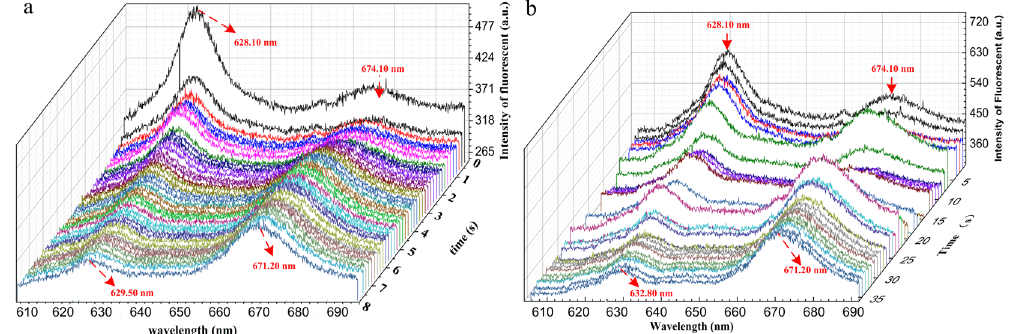
Figure 4. Monitoring the Fe 2 + and Fe 3 + combination with Protoporphyrin IX. ( a – c ) Dynamic reaction process between Fe 2 + and Protoporphyrin. The X-, Y- and Z- axis are wavelength (nm), reaction time (s) and fluorescence intensity (a.u.), respectivity; ( d – f ) Dynamic reaction process between Fe 3 + and Protoporphyrin.